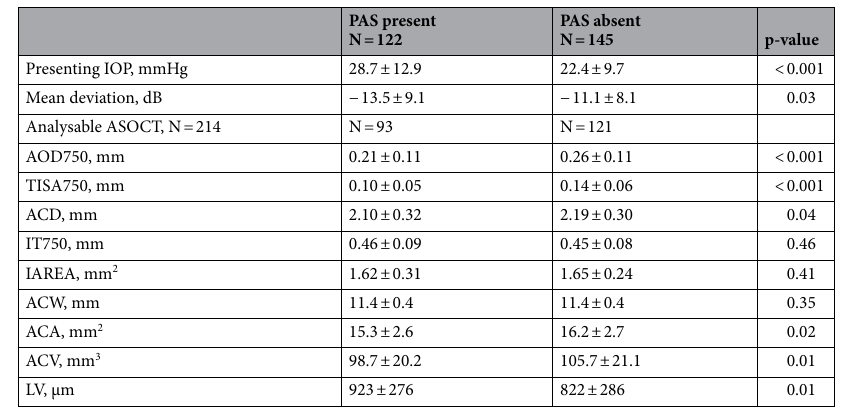
Table 3. Comparison of the presenting IOP and ASOCT parameters in eyes with and without peripheral anterior synechiae in eyes with primary angle closure glaucoma. IOP intraocular pressure, ASOCT anterior segment optical coherence tomography, ACD anterior chamber depth, AOD750 angle opening distance at 750 µm from the scleral spur, TISA750 trabecular–iris space area at 750 µm from the scleral spur, IT750 iris thickness at 750 µm from the scleral spur, IAREA iris area, ACW anterior chamber width, ACA anterior chamber area, ACV anterior chamber volume, LV lens vault.